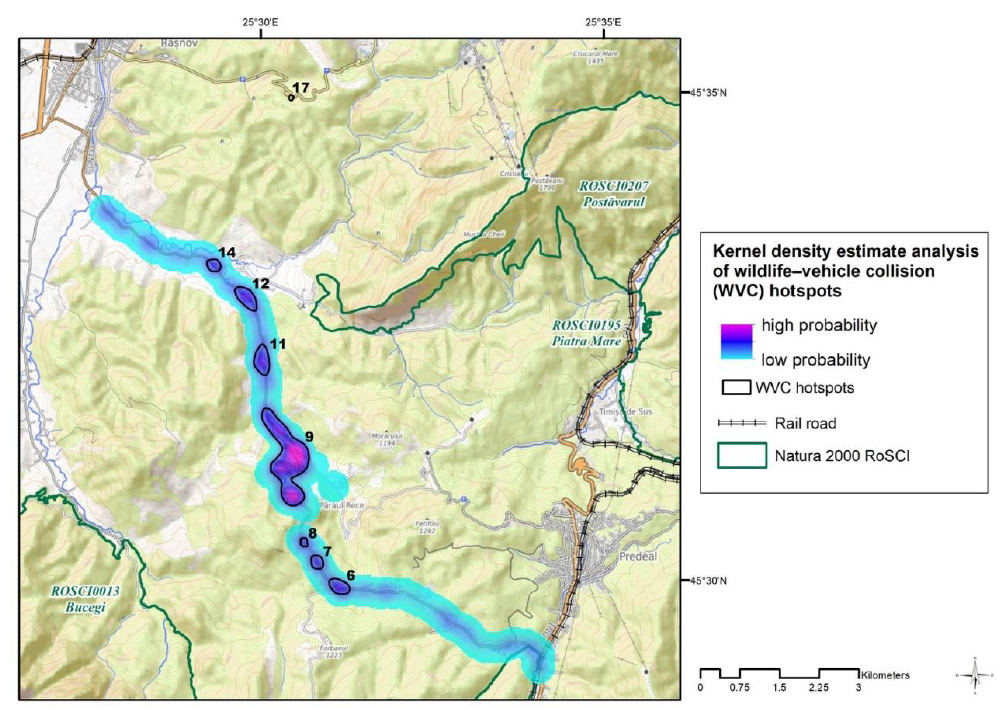
Figure 3. Model-based estimation of collision risk for Sacele – Maneciu (DN1A). High probability is represented in purple, and the WVC hotspot is dark circled.